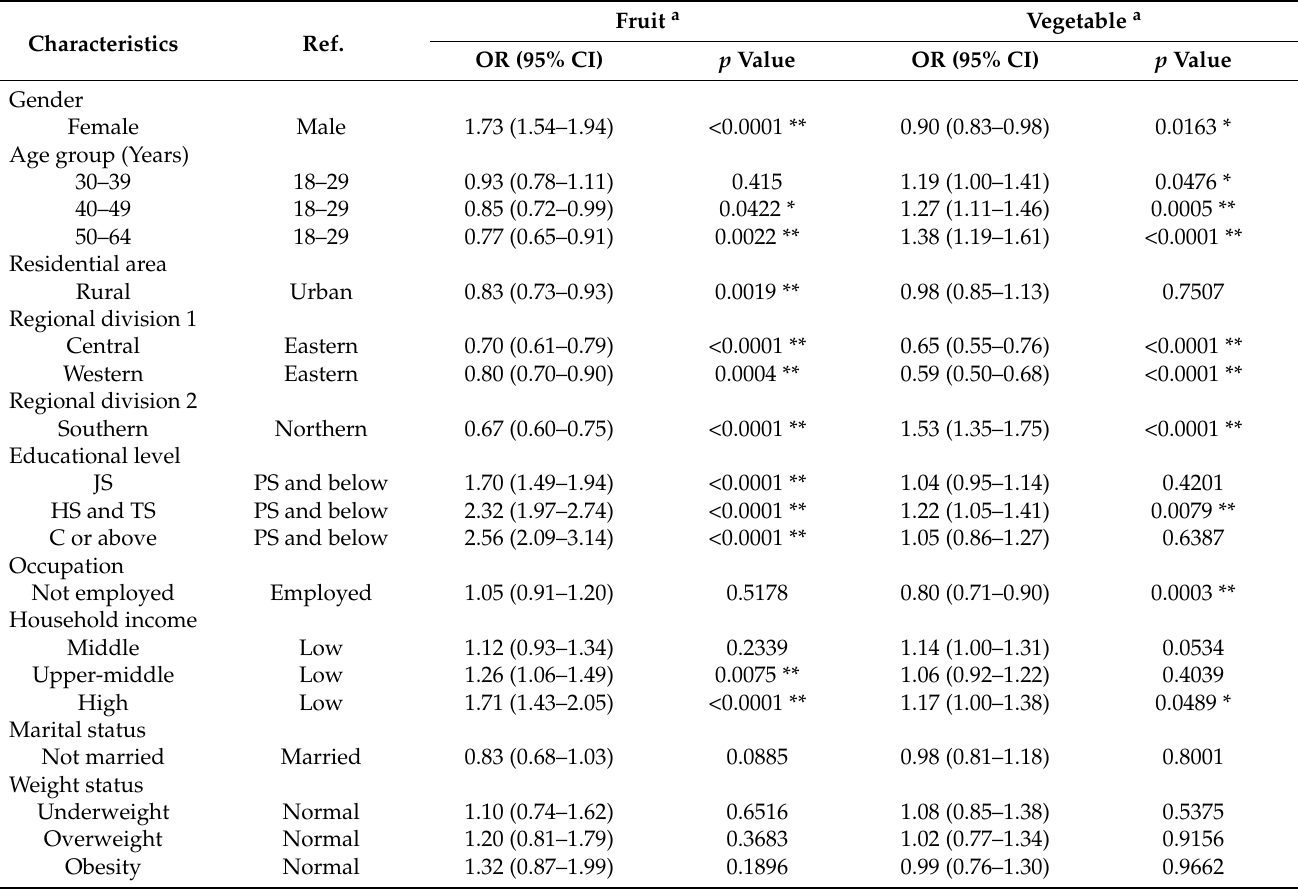
Table 4. Factors associated with fruit and vegetable